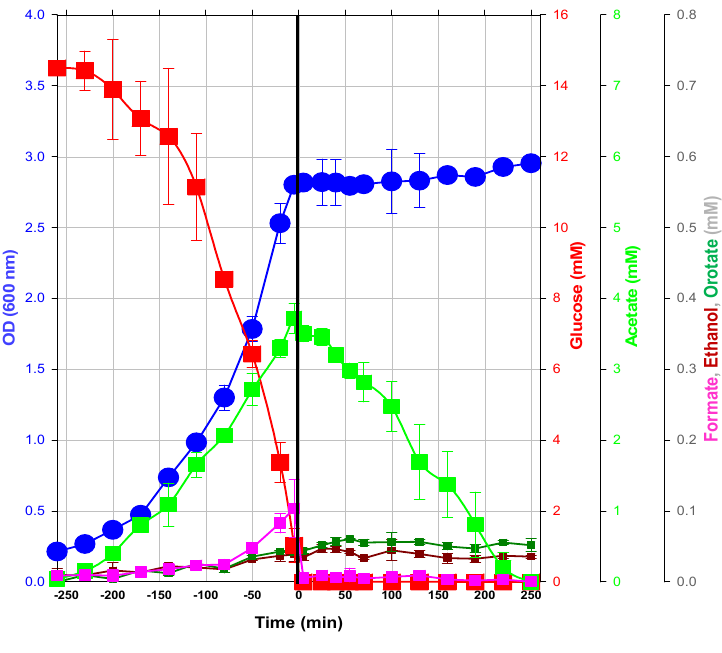
Figure 1. Physiological characterization of the glucose/acetate transition in E. coli . Three independent cultures of E. coli were grown in a bioreactor as described in the Experimental section. Time 0 was defined as the time (±30s) when the pO suddenly increased, indicating 2 complete consumption of glucose. Culture samples were collected every 10 to 30 min to measure growth (OD: Optical Density at 600 nm) and extracellular metabolite